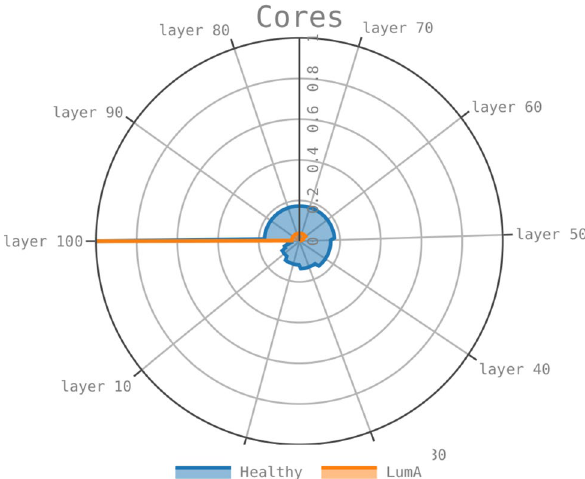
Figure 11. Conservation rate ( ccr ) of genes in the intersection of the 30-core of healthy (blue) and Luminal A (orange) tissues across 100 co-expression layers of 100,000 interactions each. Layers of coexpression move in clockwise sense from layer 100 (left) to layer 0. ccr is indicated in the concentric circles, the outer circle represents a ccr = 1 , meanwhile a ccr = 0 is placed in the center of the circle. Notice that for the case of LumA intersection, conserved genes in the following co-expression layers rapidly dissapear.